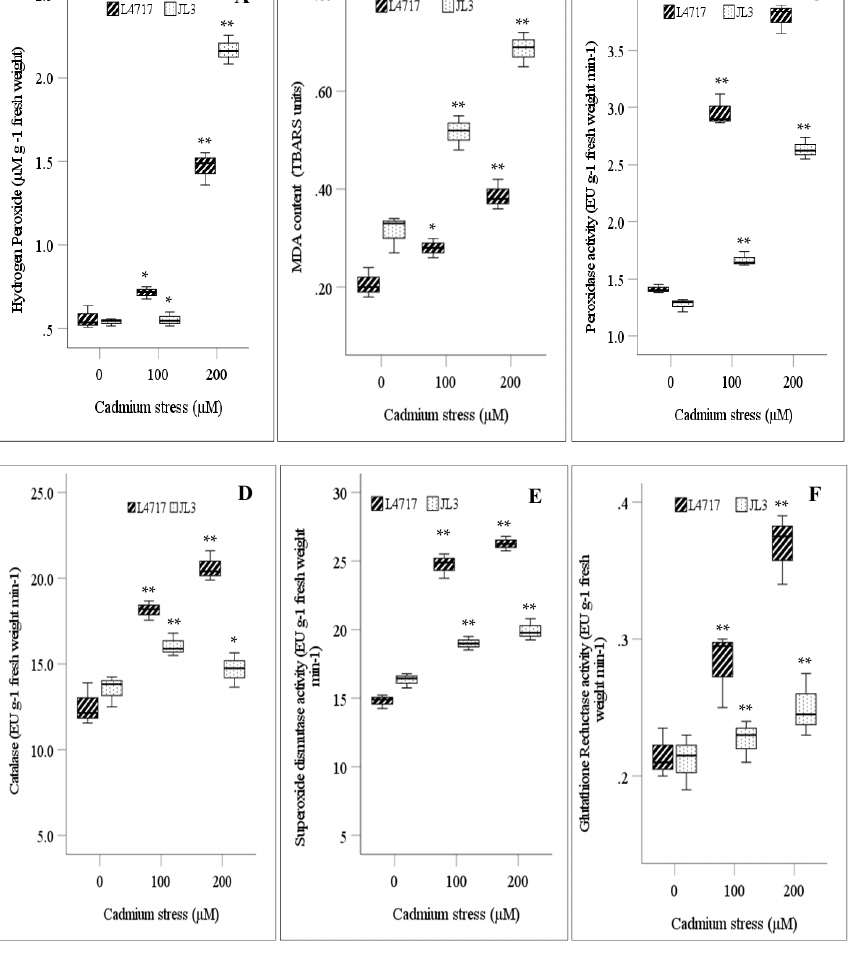
Figure 1. Changes in ( A ) hydrogen peroxide, ( B ) malondialdehyde, ( C ) peroxidase, ( D ) catalase, ( E ) superoxide dismutase, and ( F ) glutathione reductase activity in lentil seedlings under Cd stress. The central bar in each box represents the median, and each box shows the interquartile range. * and ** indicate significant differences among treatments at p < 0.05 and p < 0.01, respectively.